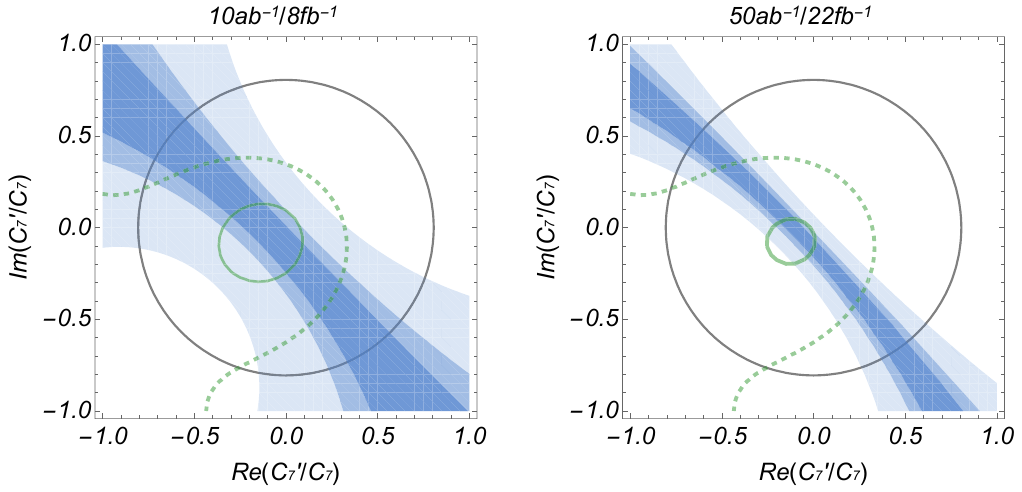
Figure 6 . Prospects for constraining, at the three standard-deviations level, Re ( C ) and (cid:31) 7 /C 7 Im ( C ) from the proposed observable . The colour changes from dark blue to light blue (cid:31) 7 /C 7 S − 0 . 5 , 0 . 3 , 0 . 15 . The corresponding for increasing values of the hadronic parameter b I = {− − − } = 0 . 30 , 0 . 18 , 0 . 10 are chosen to match those used for in figure 5, with values of { } S π + π − K 0 S γ S − similar uncertainties. The uncertainty on the hadronic parameter b I is accounted for, assuming ) / √ 2. All uncertainties are further scaled according to the increase of integrated σ (b I ) = σ ( D luminosity. The grey and green contours are described in figure